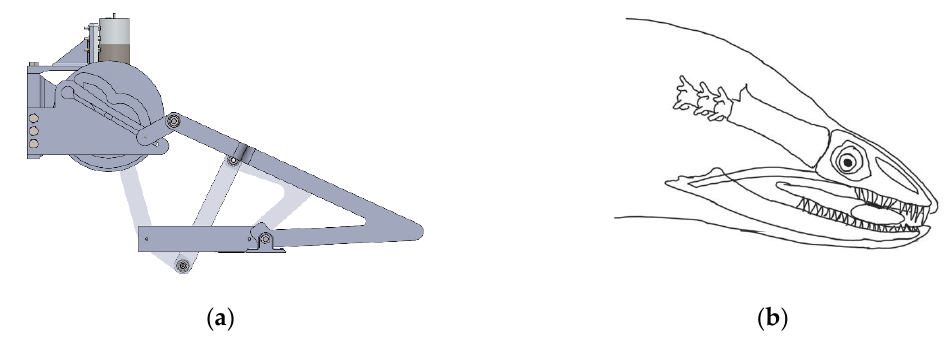
Figure 21. The oral jaw at biting instant: ( a ) as the mechanism; ( b ) as the moray illustration.